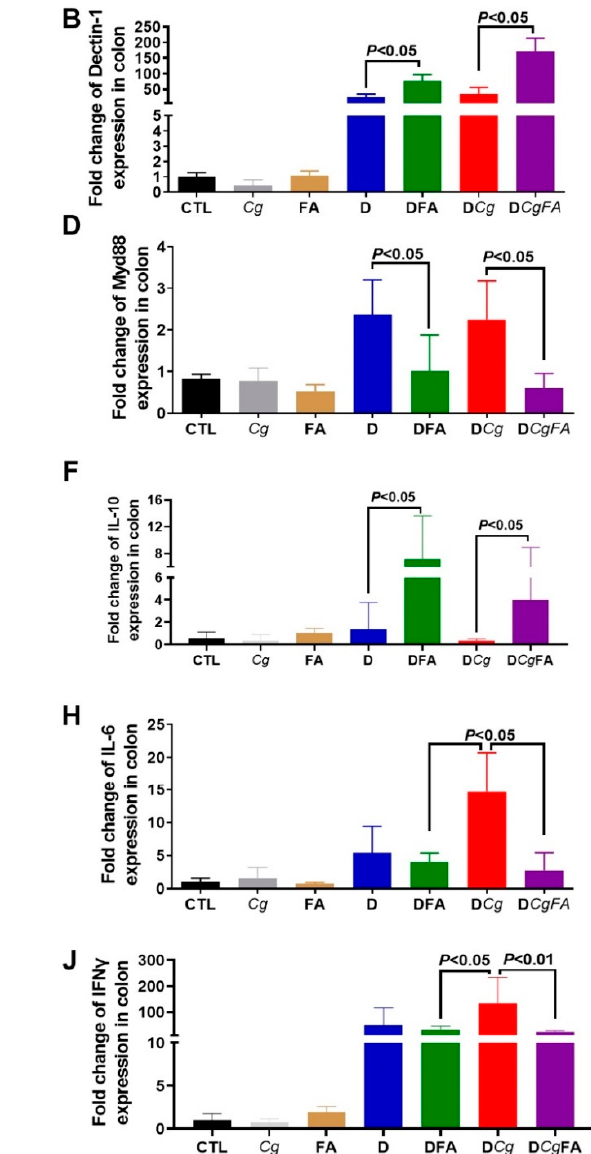
Figure 10. Cytokine and receptor expression after FA treatment. ( A – J ) Relative expression levels of TLR8, dectin-1, AhR, Myd88, FOXP3, IL-10, IL-1 β , IL-6, TNF α , and IFN γ mRNA in mouse colons. Data are the mean ± SD of six mice per group.